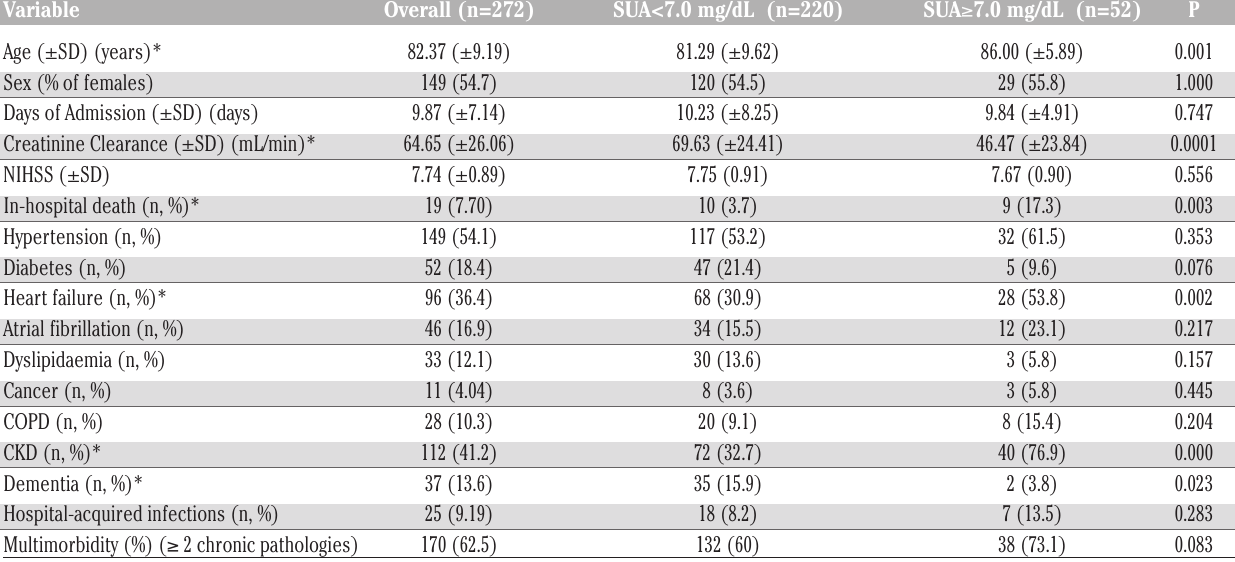
Table 1. Baseline characteristics of the sample according serum uric acid levels (cut-off ≥ 7.0 mg/dL).